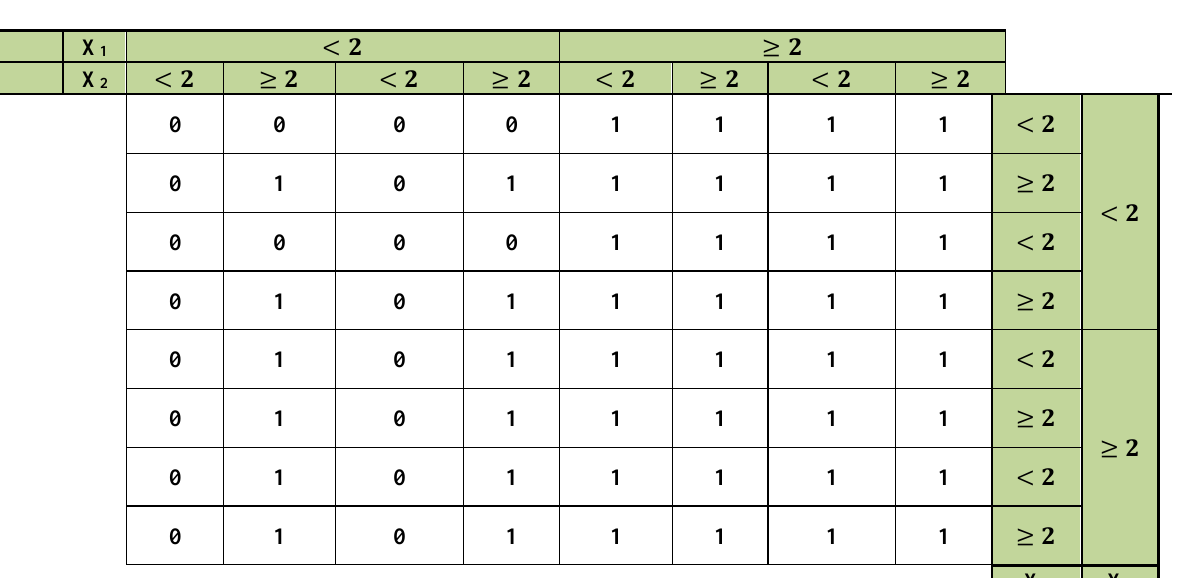
Figure 4. Reduction of the MVKM of Figure 1 to a Marquand diagram, which represents a binary function 𝑆{≥ 2} in terms of four binary variables. The diagram suffers of redundancy and lack of visual adjacency among neighboring cells, two notorious properties inherited from its parent coherent MVKM, in Figure 1.